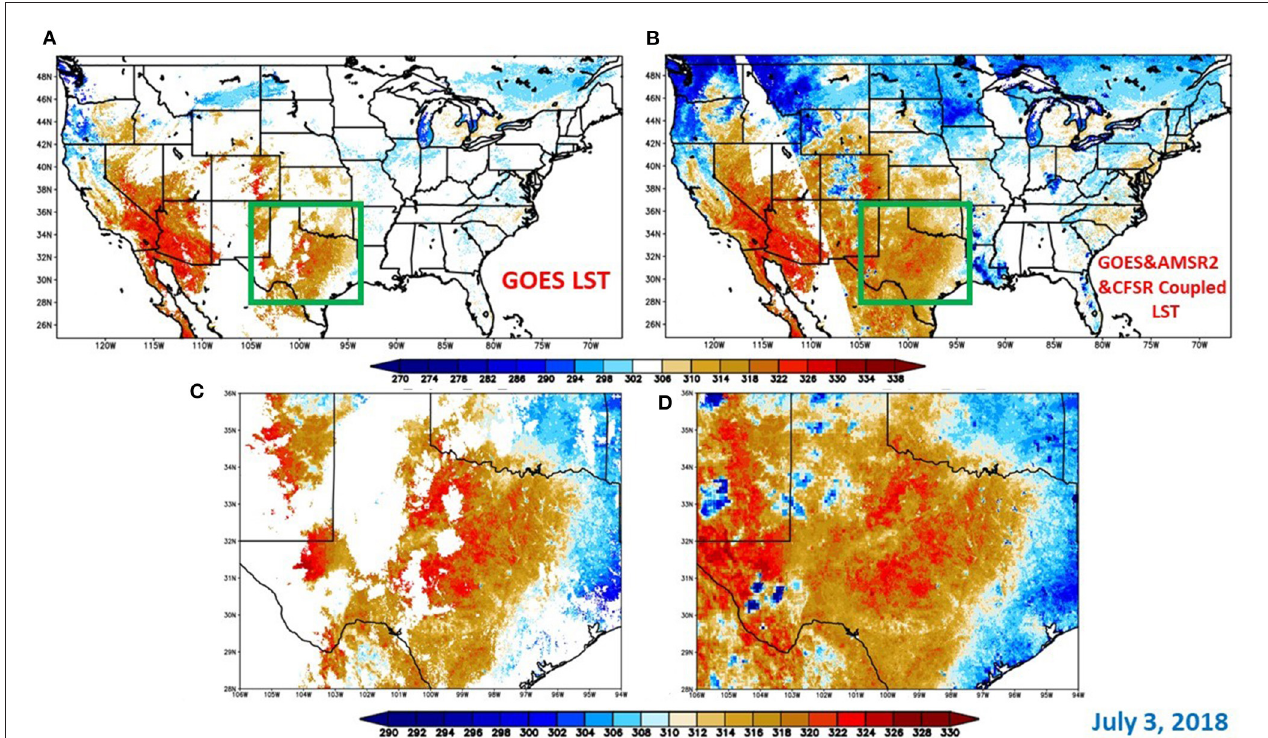
FIGURE 5 | Visual comparison between GOES LST (A,C) and MW/TIR/LSM coupled LST (B,D) at ALEXI Time 2 (1.5 local hour before noon); (A,B) over the CONUS domain and (C,D) over the Lower Mississippi Valley region; July 3, 2018.